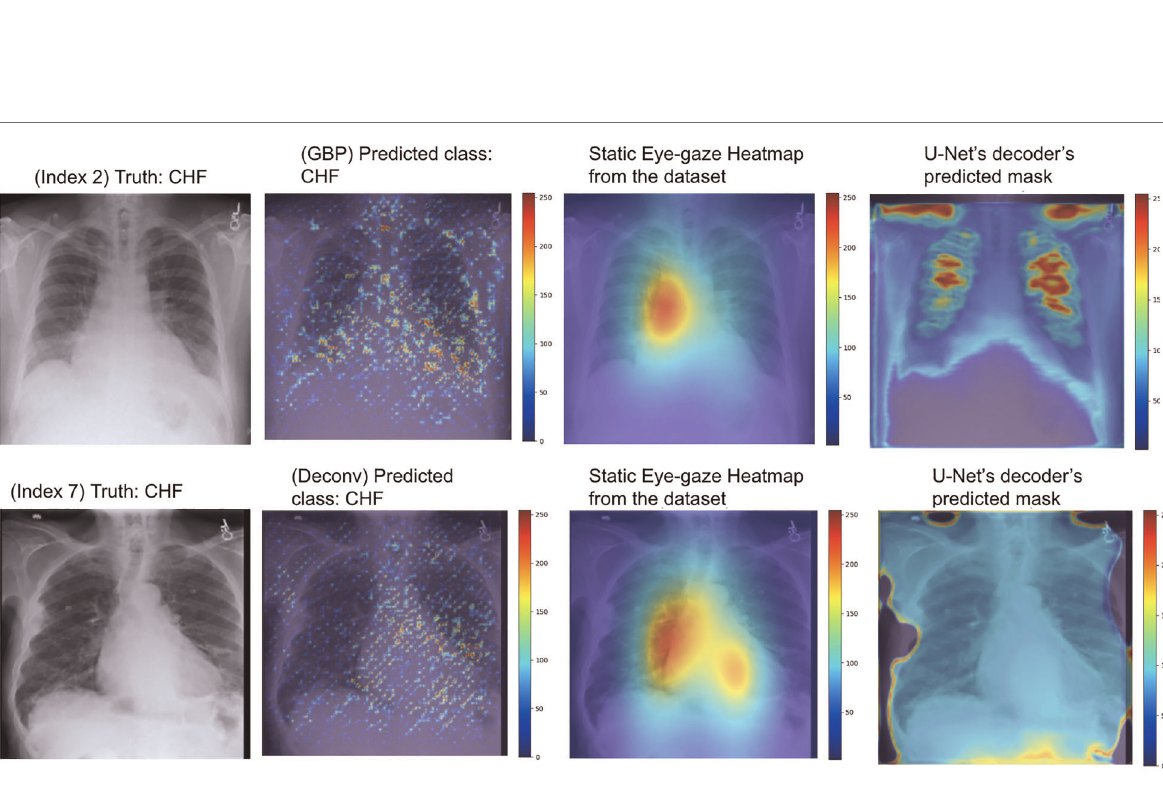
FIGURE 10 Model ’ s output heatmaps using GBP (top) and deconvNet (bottom) as the heatmap generator for Experiment Set 2 for the correctly classi fi ed CHF